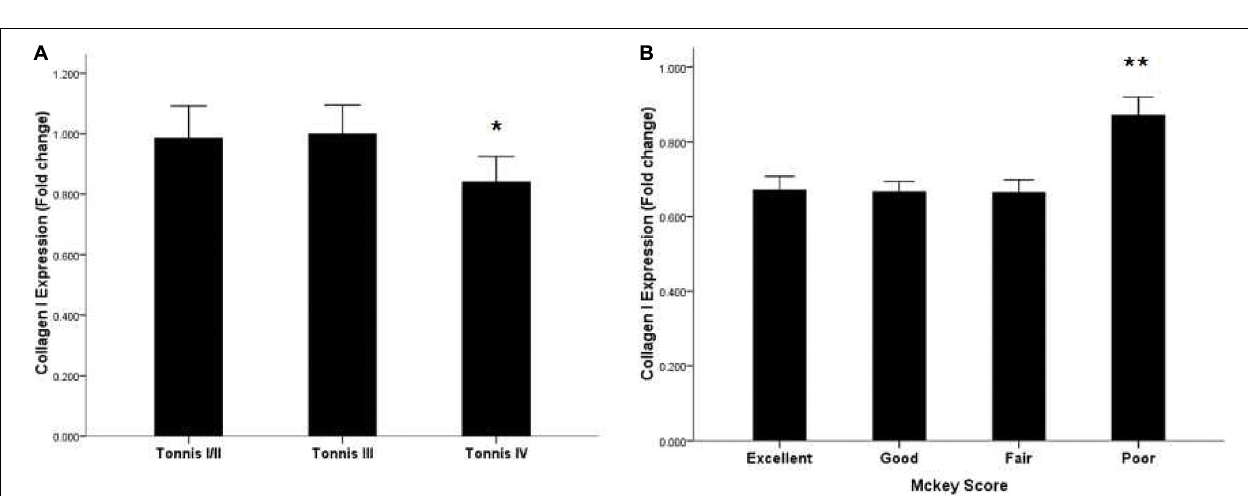
FIGURE 2 | Expression of collagen I mRNA in the capsules of DDH patients according to the Tonnis classification and McKey score. (A) Lower expression of collagen I mRNA in Tonnis IV grade patients. (B) Highest expression of collagen I mRNA in poor-group patients according to McKey score. * P < 0.05; ** P < 0.001.